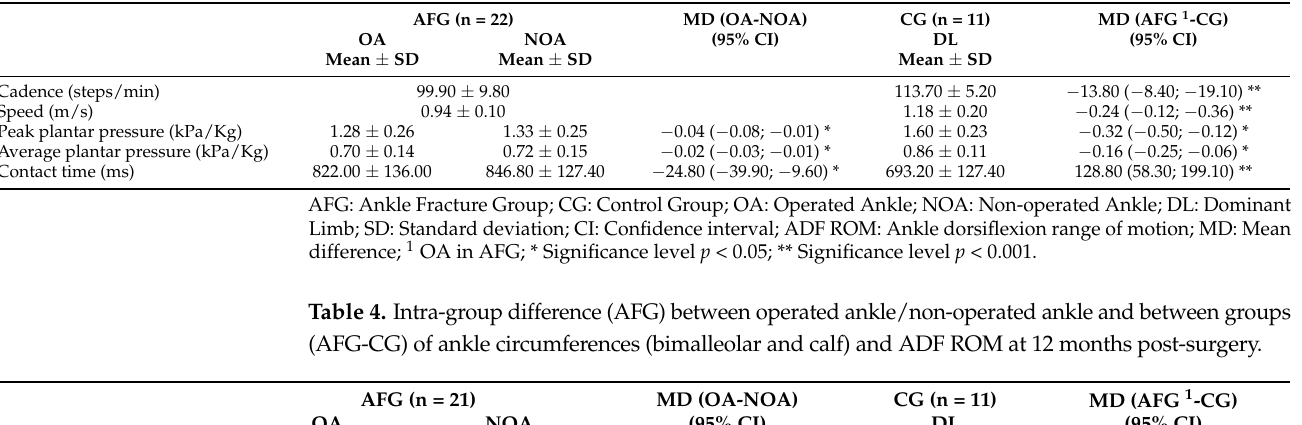
Table 3. Intra-group difference (AFG) between operated ankle/non-operated ankle and between groups (AFG-CG) of gait parameters and dynamic plantar pressure at 6 months post-surgery.